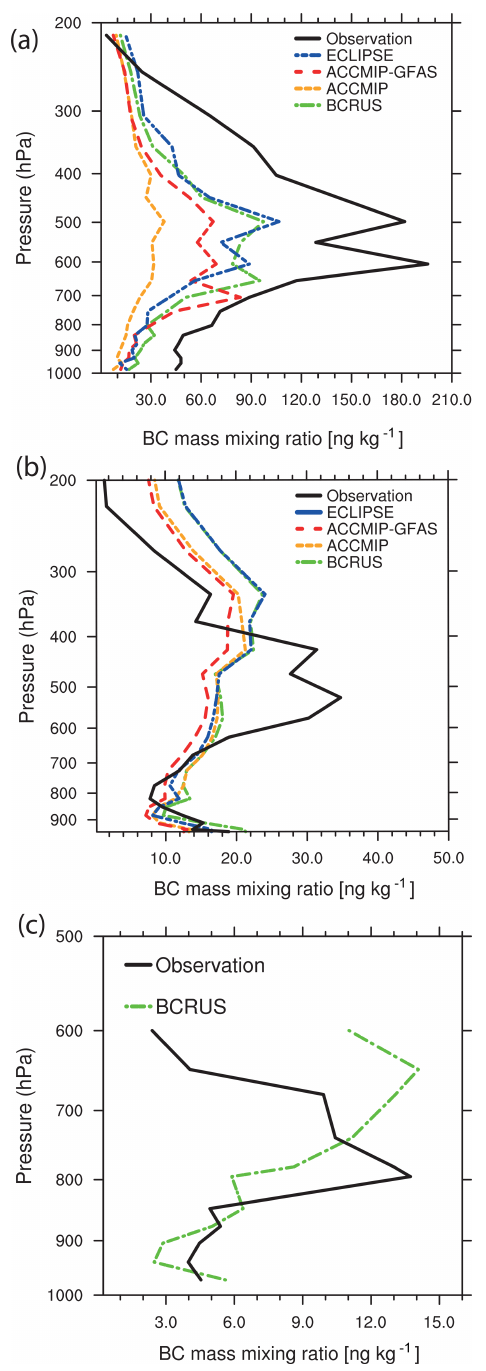
Figure 11. As in Fig. 10, but with spring campaigns (March–April– May). (a) ARCTAS spring campaign in April 2008. (b) HIPPO-3 campaign in March–April 2010. (c) ACLOUD campaign in May– June 2017. Note that for year 2017, model results are only available from the BCRUS